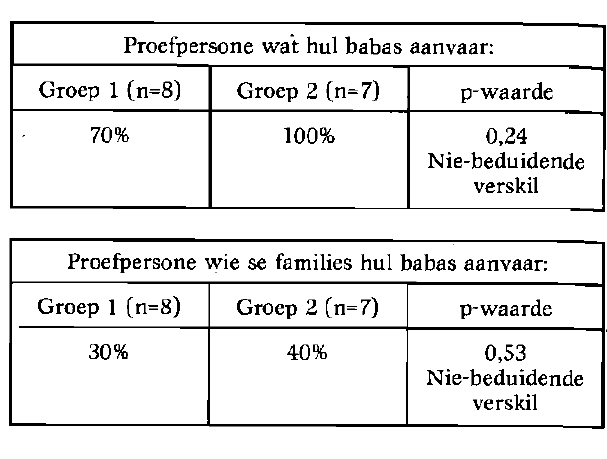
Tabel 3: Vergelyking van Groep 1 en Groep 2 se aan- vaarding van hulle gesplete-lip-en-verhemelte- babas.